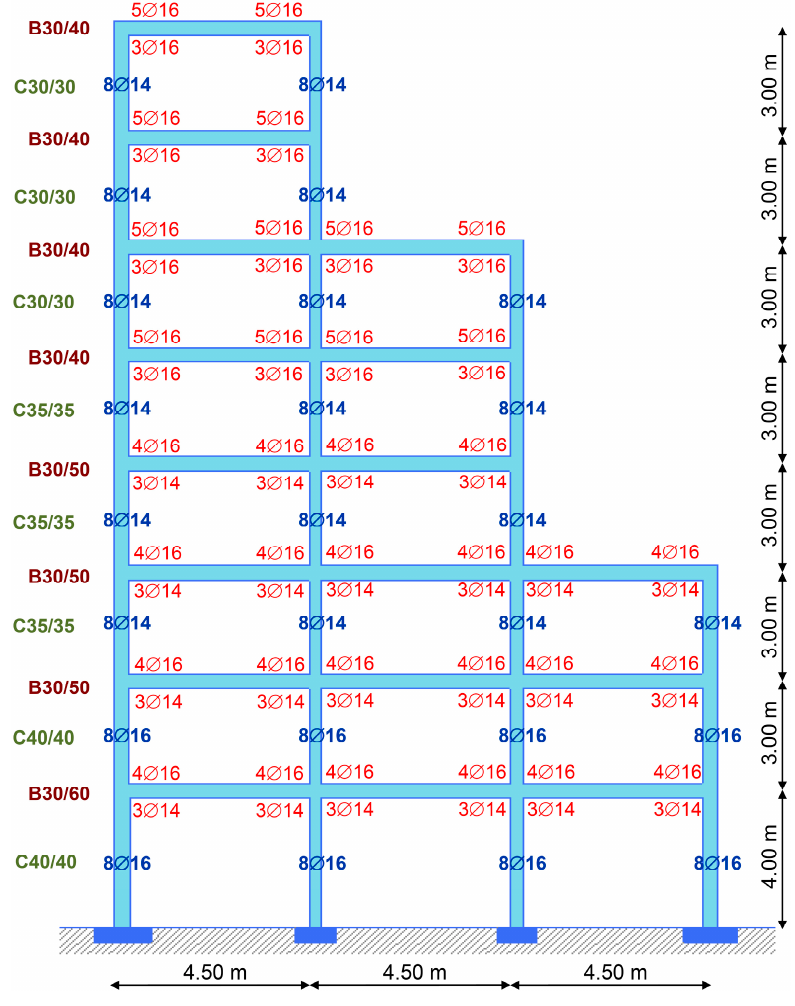
Figure 9. Frame B4 properties.